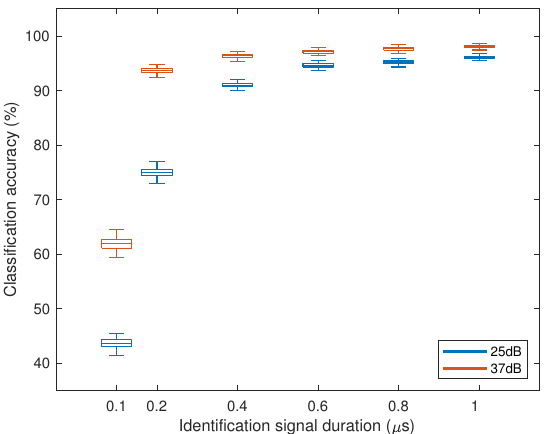
Figure 13. Classification accuracy versus identification signal